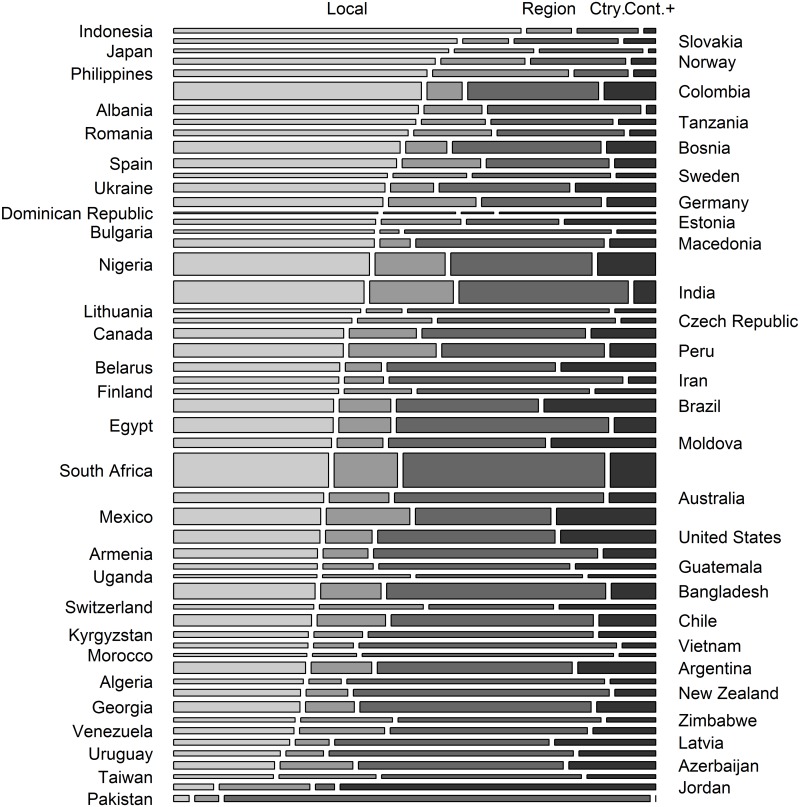
Proportion (box height) of participants with each primary geographic identity (box width) across 55 countries.“Cont.+” represents participants with a continent or world identity.